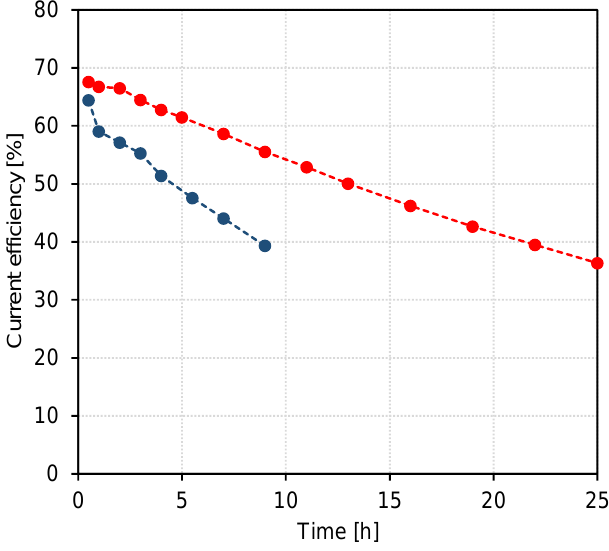
Figure 6. Current efficiency development during the EDBM experiment with BL permeate ( ● ) and BL model solution ( ● ).